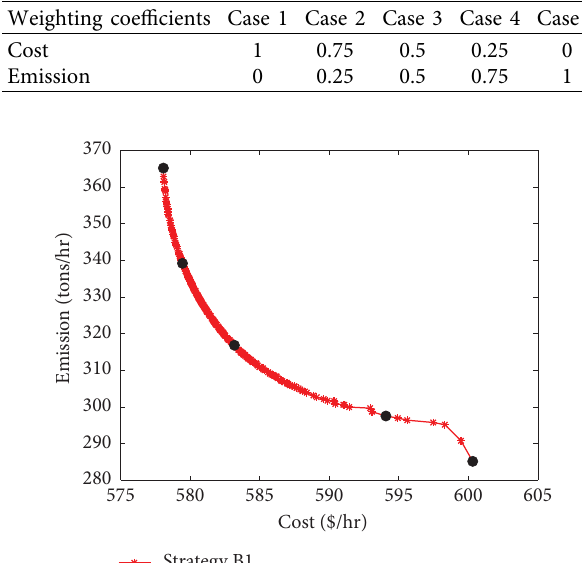
Figure 7: Pareto-optimal front for strategy B